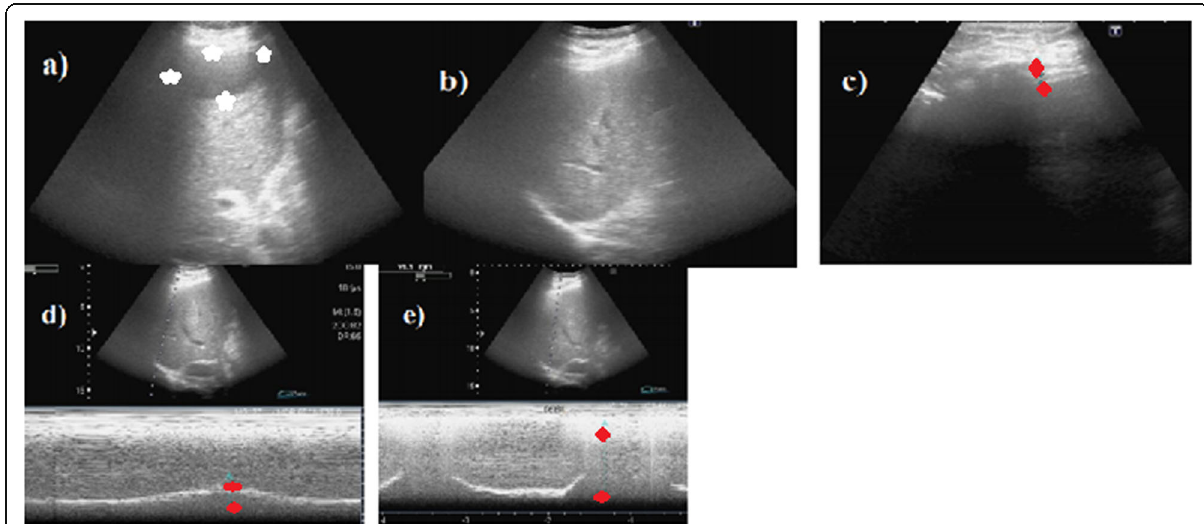
Fig. 7 a – e US images for a 72-year-old male patient presented with fever and abdominal pain, and his CT examination showed a right copula elevation. a , b US images — intercostals views — showing a loculated subphrenic collection with internal echoes (complex collection), and no internal vascularity was detected; it is seen measuring 4 × 5 cm ( a , between the white asterisks) with normal US appearance of the right hemidiaphragm showing no defects ( b ). c US image using superficial probe through an intercostal view showing a mildly thickened right hemidiaphragm = 3.7 mm (between the red dots) with adequate thickening fraction (= 48%) d , e Intercostal views used for the assessment of diaphragmatic excursion ((RT = 3 cm in normal breathing ( d , between the red dots)/= 9.3 cm in deep breathing ( e , between the red dots)/= 7.8 cm in sniffing) showing a picture of elevated right diaphragmatic copula with thickening secondary to a right subphrenic collection likely an